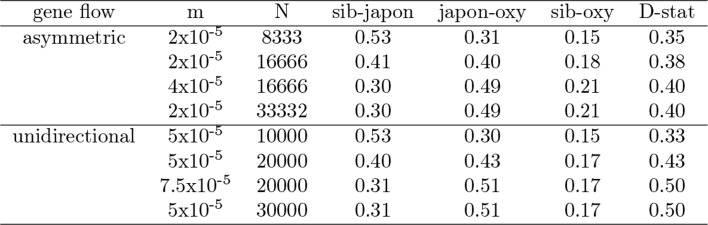
Tree topology proportions simulated under assymmetric and unidirectional models.